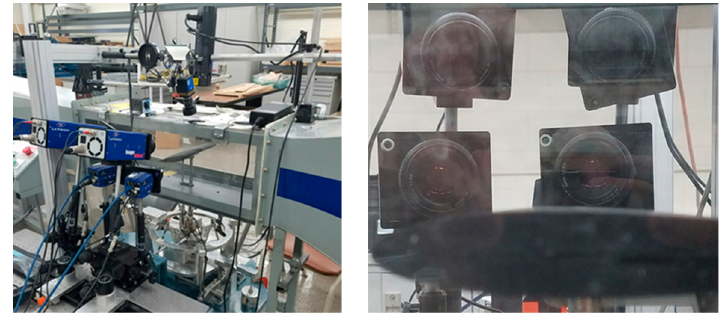
Figure 3. Tomographic setup photography. Reproduced from Stolt et al. [30].